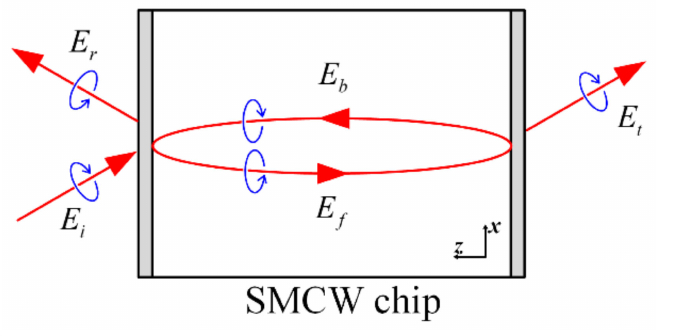
Figure 5. A simple model of the scattering of the vortex beam carrying angular momentum on an SMCW